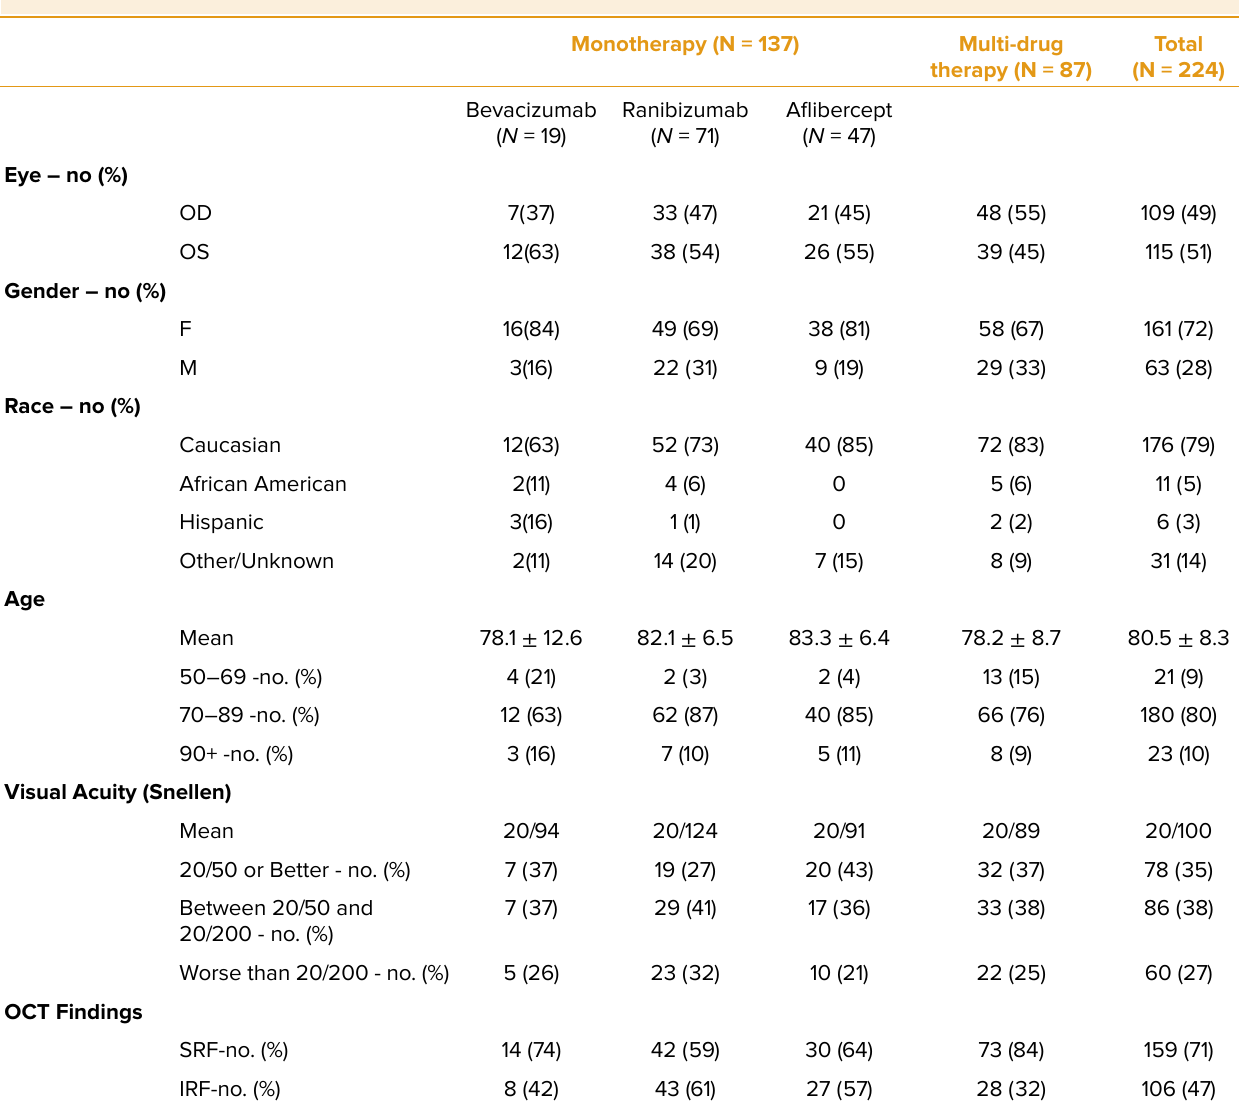
Table 1. Patient baseline